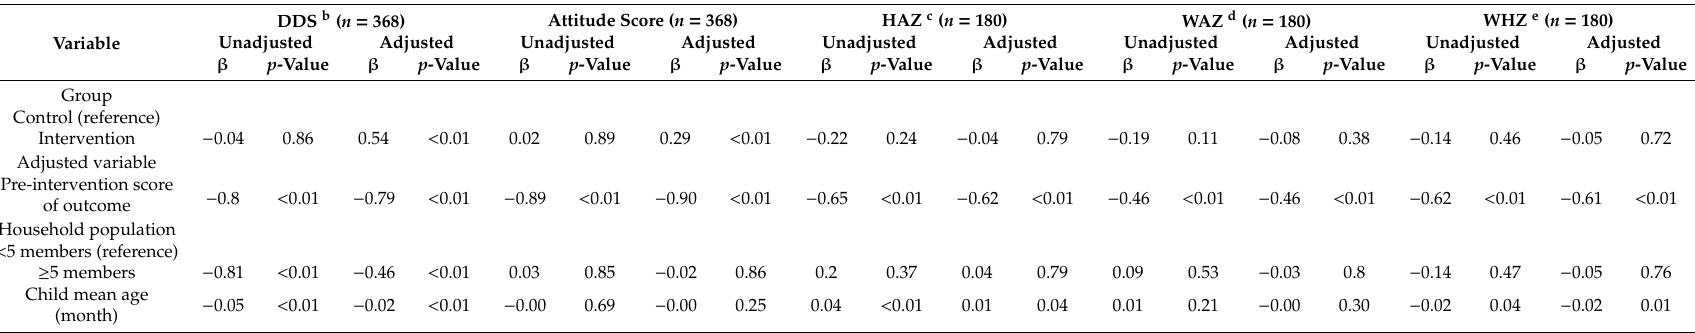
Table3. Thee ff ects a